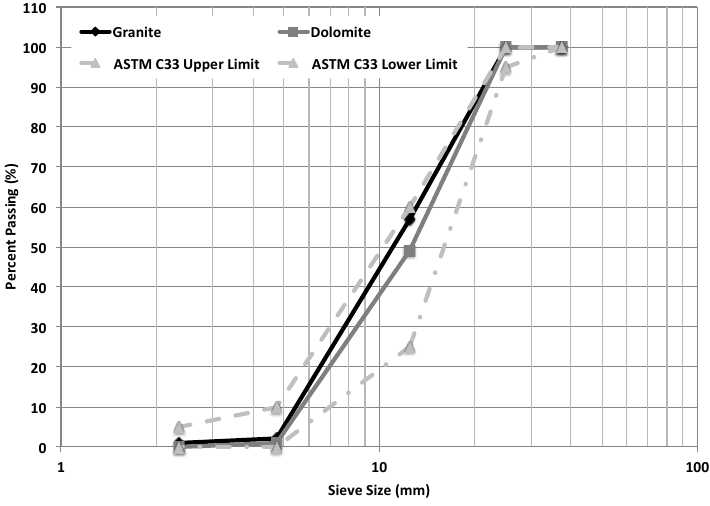
Figure 2. Gradation curves for coarse aggregates and ASTM C33 grading requirements for number 57 aggregate. Table 1. Basic physical properties of coarse aggregates and standard test methods.